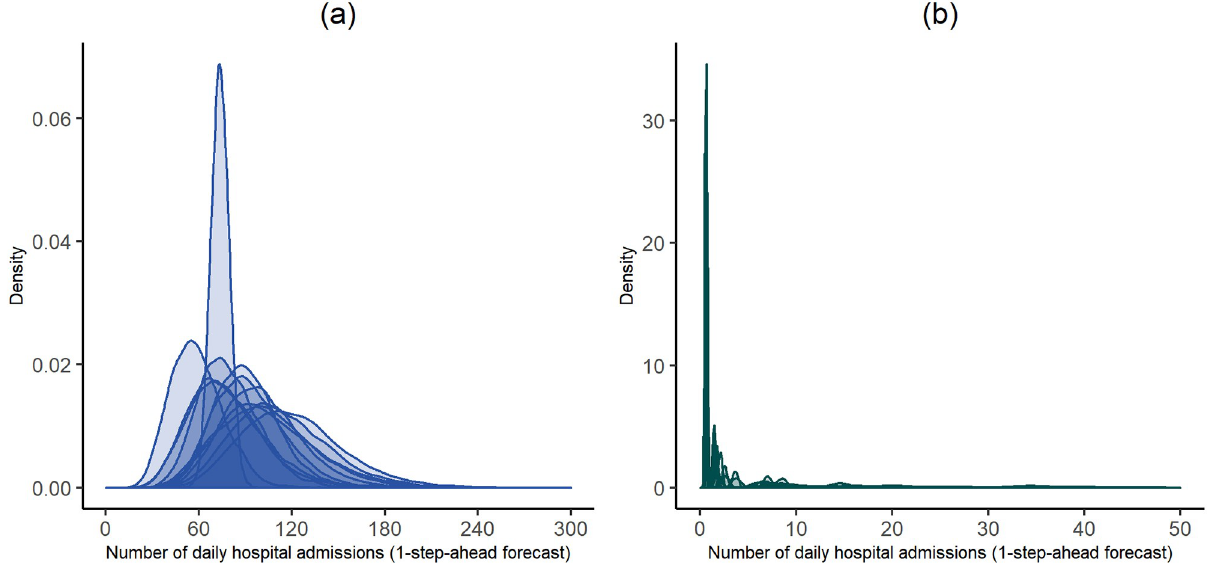
Fig 12. Estimated one-step-ahead forecast pdfs stratified by identified clusters. (a) Cluster 1 (blue) and (b) Cluster 2 (green). The scale of the x -axis decreases by a factor of 6 from one cluster to other.